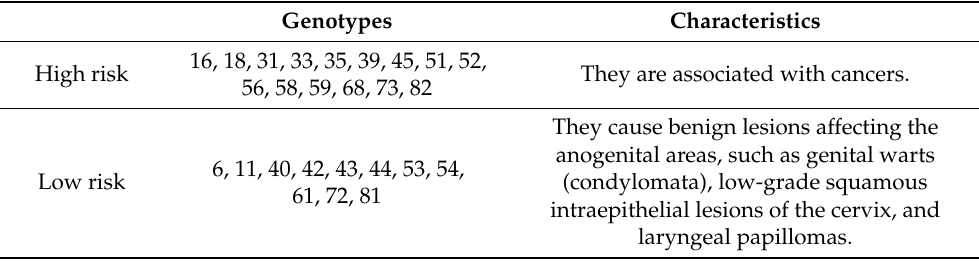
Table 1. Human papillomavirus genotypes and their oncogenic risks [6,7]. Genotypes Characteristics They are associated with cancers. They cause benign lesions affecting the anogenital areas, such as genital warts (condylomata), low-grade squamous 61, 72, 81 intraepithelial lesions of the cervix, and laryngeal